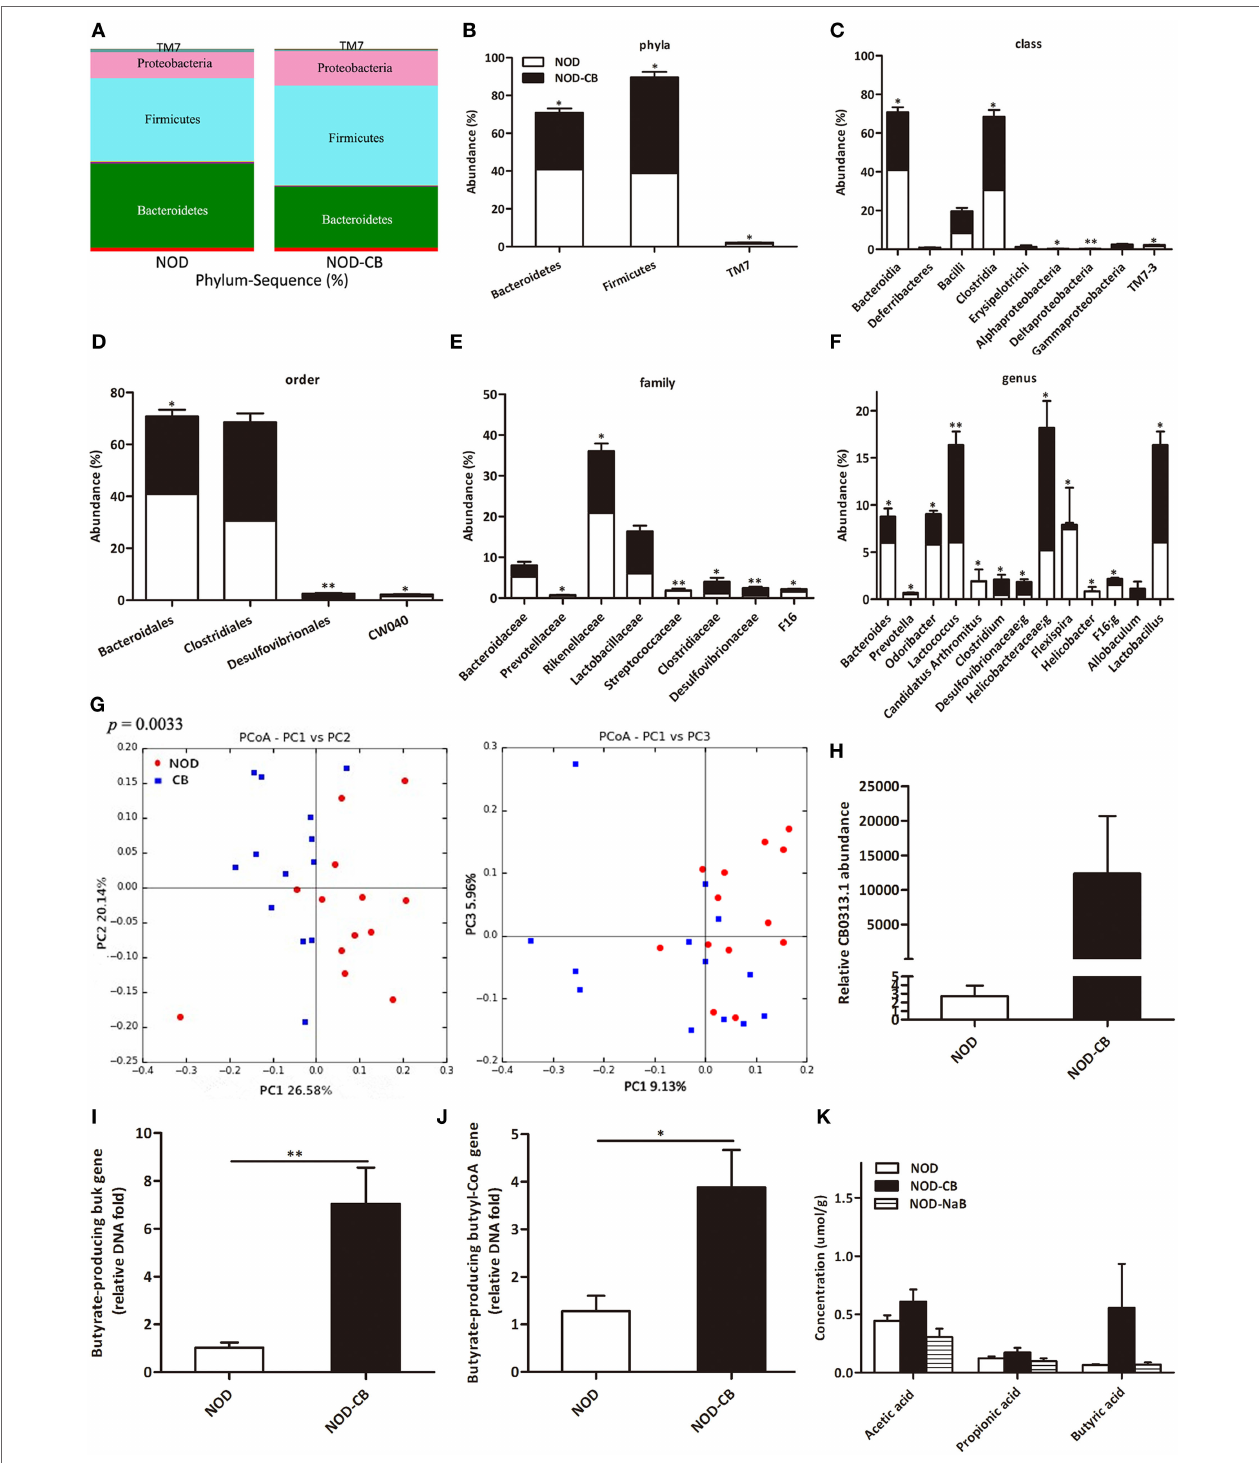
FigUre 3 | CB0313.1 restores the diabetes-induced gut microbial dysbiosis. (a,B) Abundance of the most important phyla in each group. Abundance of the main altered classes (c) , orders (D) , families (e) , and genera (F) in each group. (g) Principal coordinate analysis (PCoA) plot of weighted UniFrac distances, each dot representing a feces community; the percentage of variation explained by each principal coordinate is shown in parentheses. (h) Relative abundance of CB0313.1. Predominant butyrate producing genes: relative abundance of butyrate kinase ( buk ) and butyryl-CoA DNA in feces (i,J) . (K) SCFA concentration in feces measured by GC-MS. Analysis of variance followed by the indicated post hoc test was performed to determine the significance among the three groups. Data are mean ± SEM ( n = 8 mice per group). *, **, *** p < 0.05, p < 0.01, p < 0.001 vs NOD control mice by t -test.